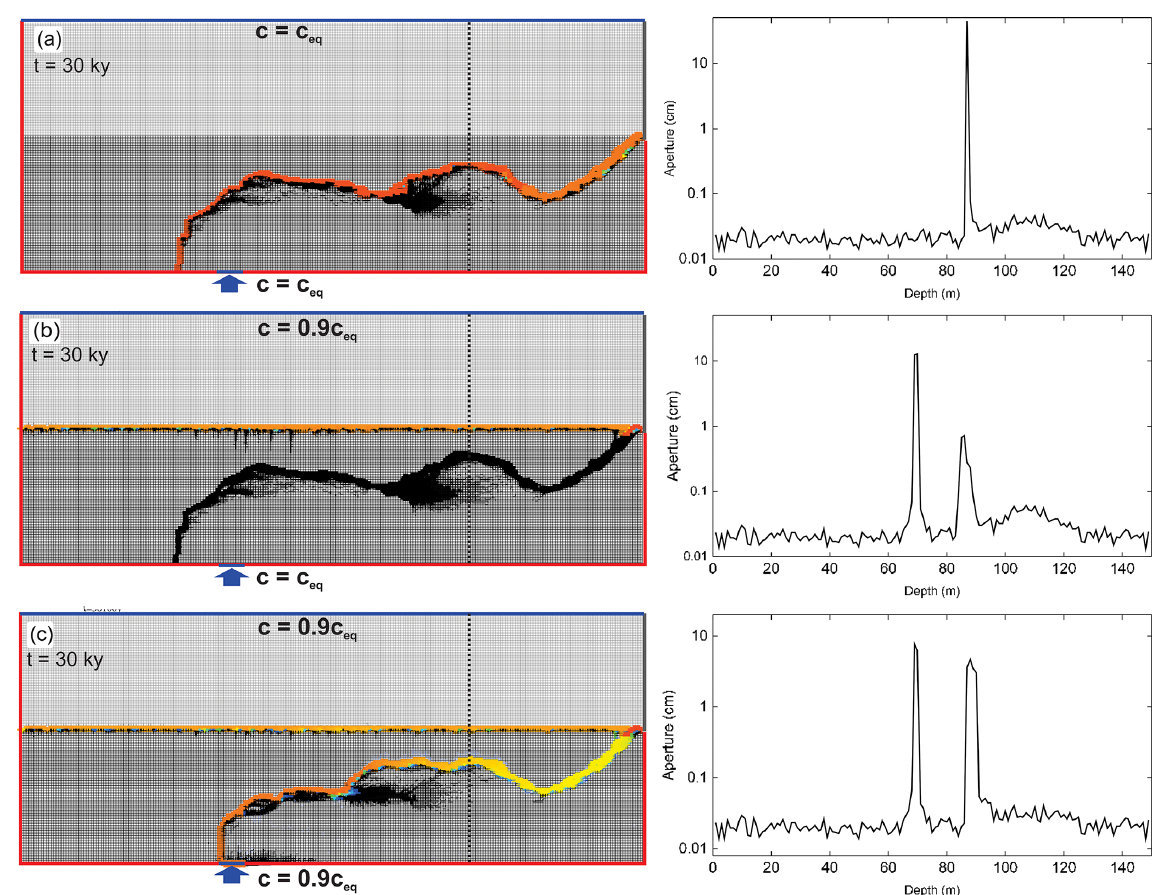
Figure 15. Final evolution states of scenario A, Fig. 13, scenario B, Fig. 14, and standard scenario C, Fig. 4. Panels on the right show widths of horizontal fractures along profile lines shown in (a–c)